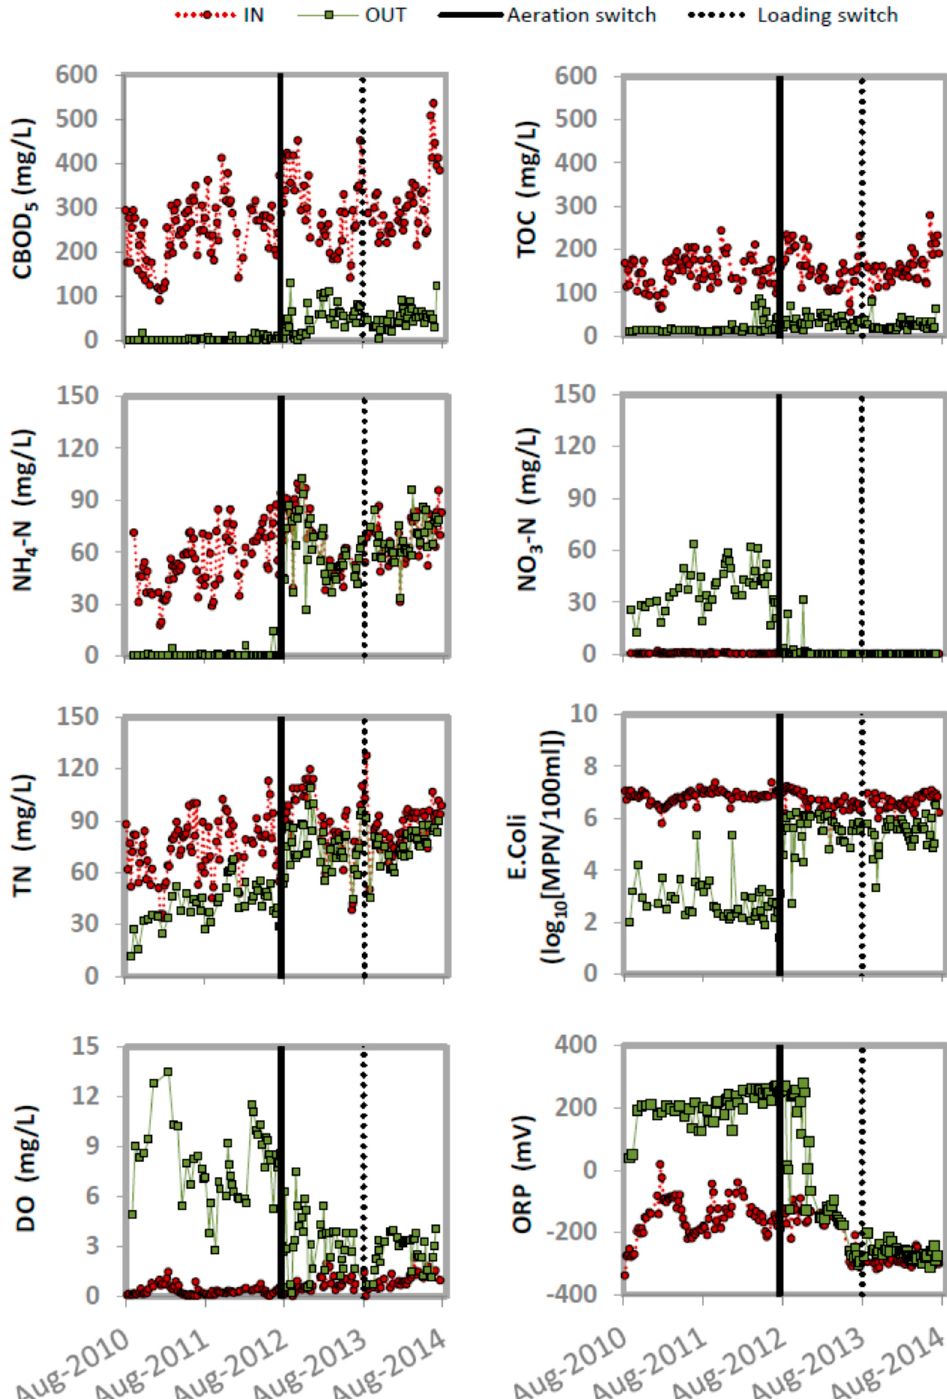
Figure 4. Time series of influent (red dotted line, circular markers) and effluent (green solid line, squared markers) concentrations. The vertical solid line indicates the switch from electrical to wind ‐ driven aeration and the vertical dotted line refers to the reduction of the hydraulic loading rate from 130 to 65 L ∙ m − 2 ∙ d − 1 .